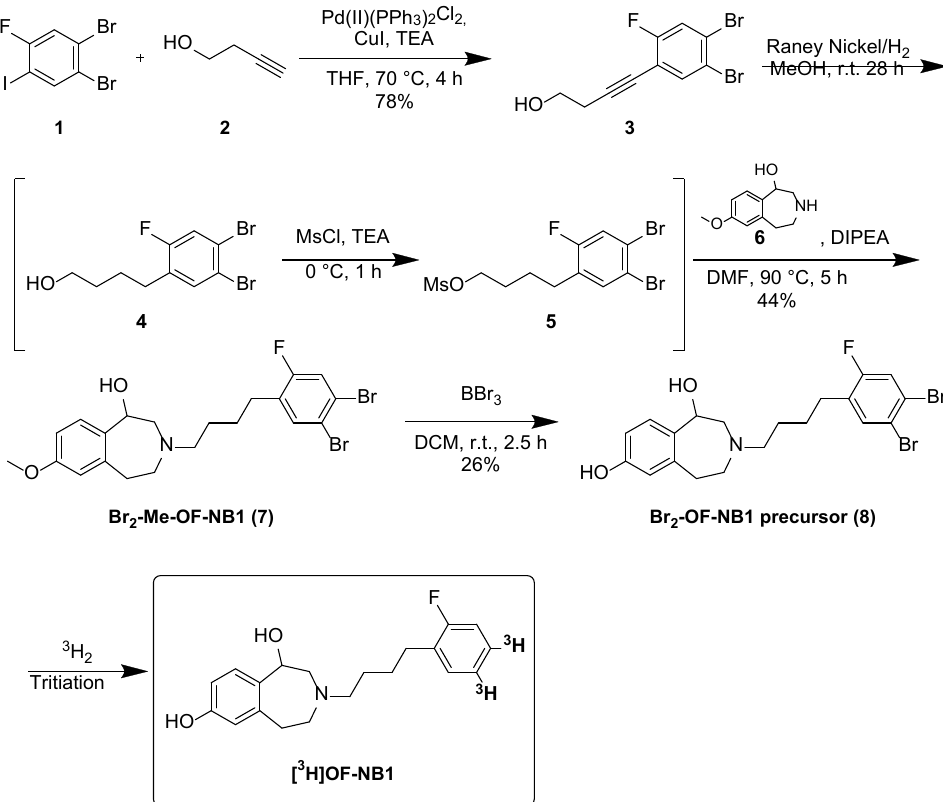
Scheme 1. Synthetic pathway toward dibromo precursor 8 and [ 3 H]OF-NB1.